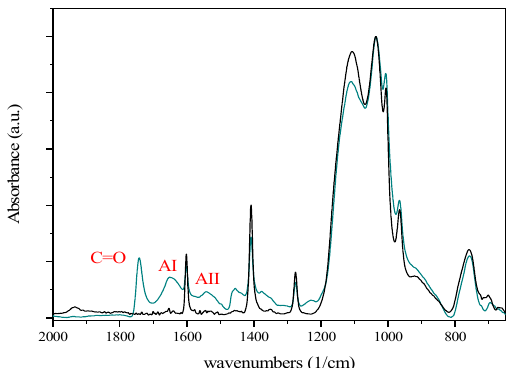
Figure 7. Micro-FT-IR spectra of unconjugated NH 2 -NPs (black line) and HA-NPs (dark cyan line). Table 2. Loading of anti-cancer drug into unconjugated and conjugated NPs.